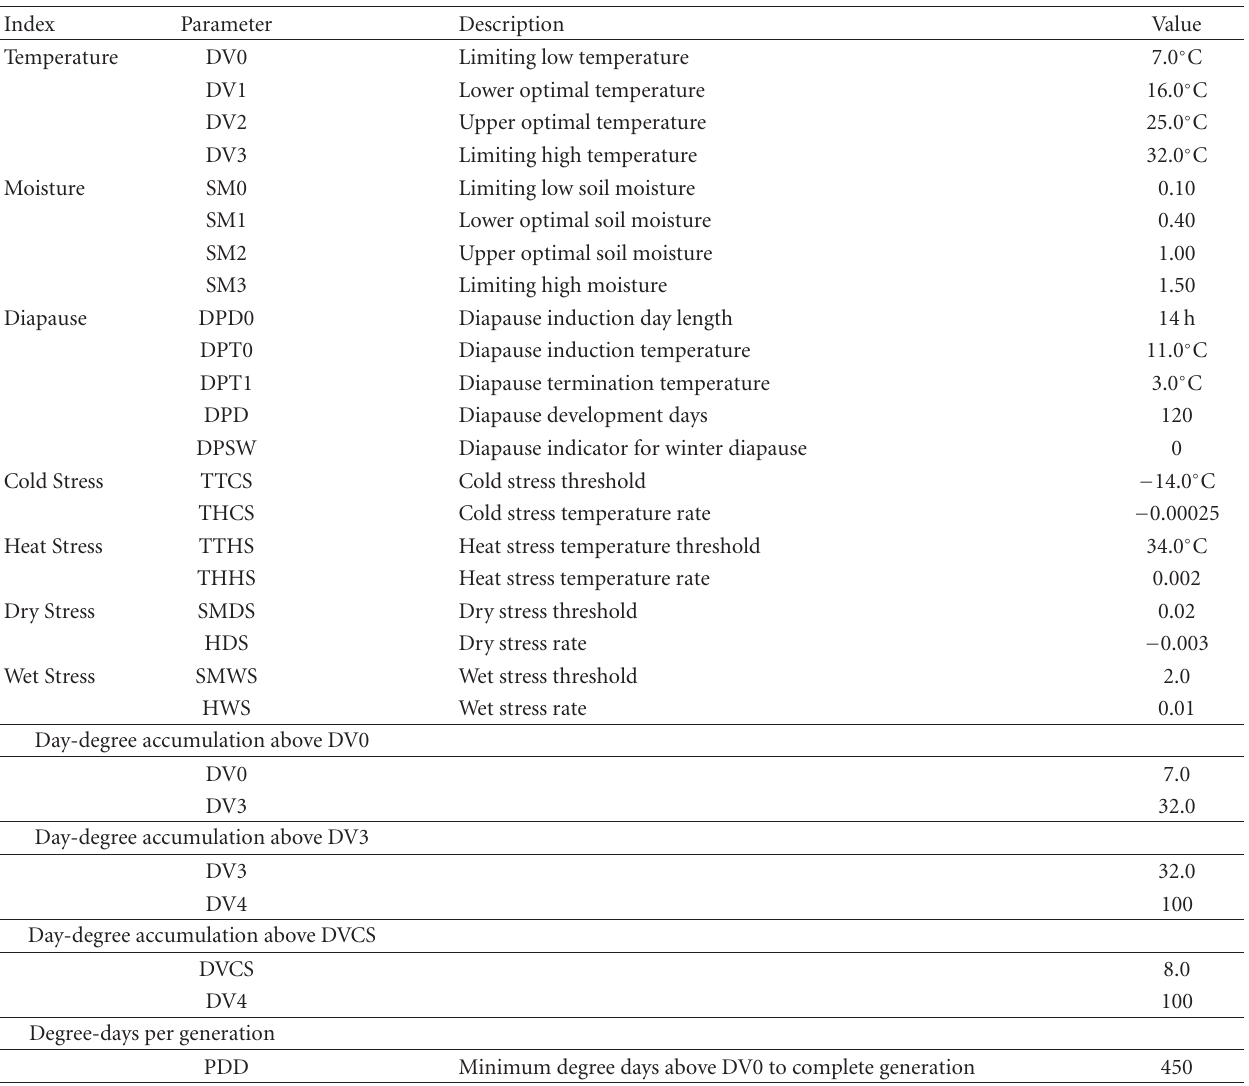
Table 1: Descriptions of CLIMEX parameters and parameter values used to predict the potential distribution and relative abundance of Sitona lineatus in North